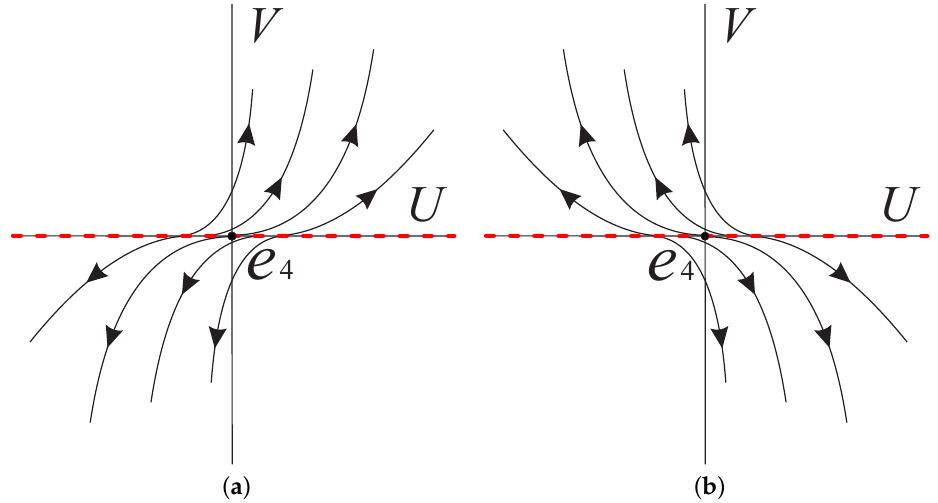
Figure 3. The local phase portrait at the equilibrium point e 4 = ( 0,0 ) of system (15) in ( a ) when s > 0, and in ( b ) when s <